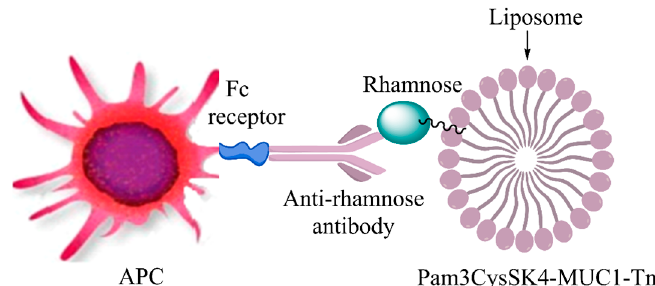
Figure 2. Antibody-mediated antigen uptake mechanism. Anti-rhamnose antibody binding to rhamnose on the vaccine allows recognition by Fc receptor (FcR) on antigen presenting cells and enhanced uptake.